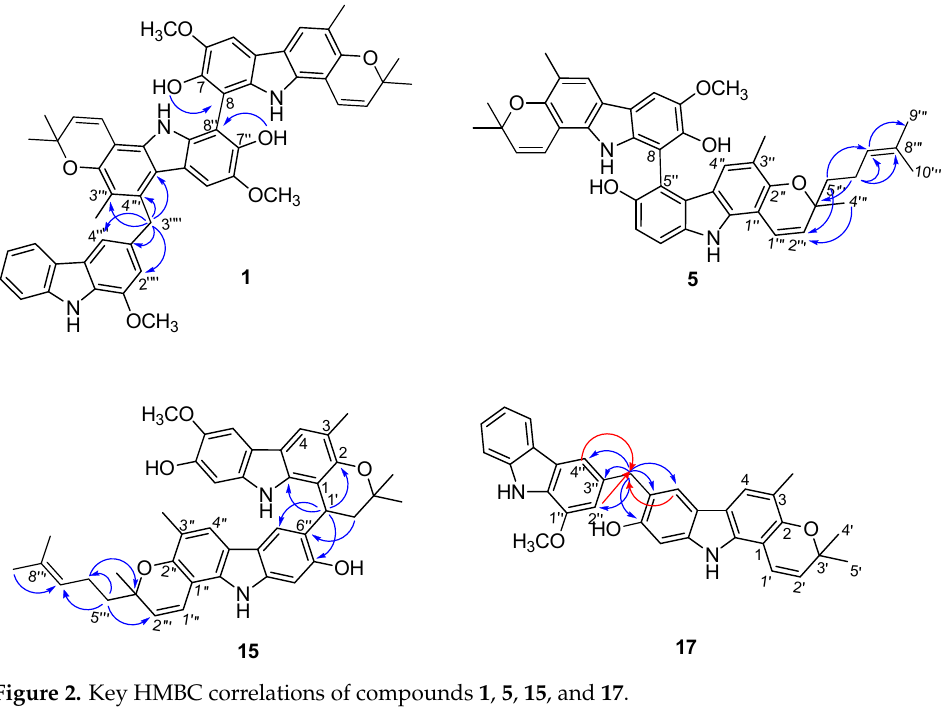
Figure 3. The chiral HPLC separation ( A ) and experimental and calculated ECD data ( B ) of com- pounds 1a and 1b. ( ± )-Microphyldine A ( 2 ) was obtained as a brown amorphous powder, and its molec- ular formula was determined as C 37 H 34 N 2 O 5 from the 13 C nmR spectroscopic data and the HRESIMS ion at m / z 585.2387 [M − H] − (calcd. for C 37 H 33 N 2 O 5 , 585.2389). Four labile proton signals ( δ H 7.43 (1H, br s, 7-OH), 7.43 (1H, br s, 7 (cid:48)(cid:48) -OH), 9.58 (1H, br s, 9-NH), 10.14 (1H, br s, 9 (cid:48)(cid:48) -NH)), five aromatic singlet protons ( δ H 7.04 (1H, s, H-8 (cid:48)(cid:48) ), 7.61 (1H, s, H-5), 7.63 (1H, s, H-4 (cid:48)(cid:48) ), 7.65 (1H, s, H-4), 7.87 (1H, s, H-5 (cid:48)(cid:48) )), a methoxy group ( δ H 4.02 (3H, s, 6-OCH 3 )), two methyl groups ( δ H 2.29 (3H, s, 3 (cid:48)(cid:48) -CH 3 ) 2.31 (3H, s, 3-CH 3 )), and two 2,2-dimethyl-2 H -pyran moieties ( δ H 1.42/1.49 (each 3H, s, H-5 (cid:48) /H-5 (cid:48)(cid:48)(cid:48) ), 1.43/1.50 (each 3H, s, H-4 (cid:48) /H-4 (cid:48)(cid:48)(cid:48) ), 5.58/5.80 (each 1H, d, J = 10 Hz, H-2 (cid:48) /H-2 (cid:48)(cid:48)(cid:48) ), 6.87/6.94 (each 1H, d, J = 10 Hz, H-1 (cid:48) /H-1 (cid:48)(cid:48)(cid:48) )) were observed in the 1 H nmR data (Table 2). The 13 C nmR data (Table 3) showed 37 carbon resonances, comprising 30 olefinic, six methyl, and one methoxy carbons. The above data, coupled with information from